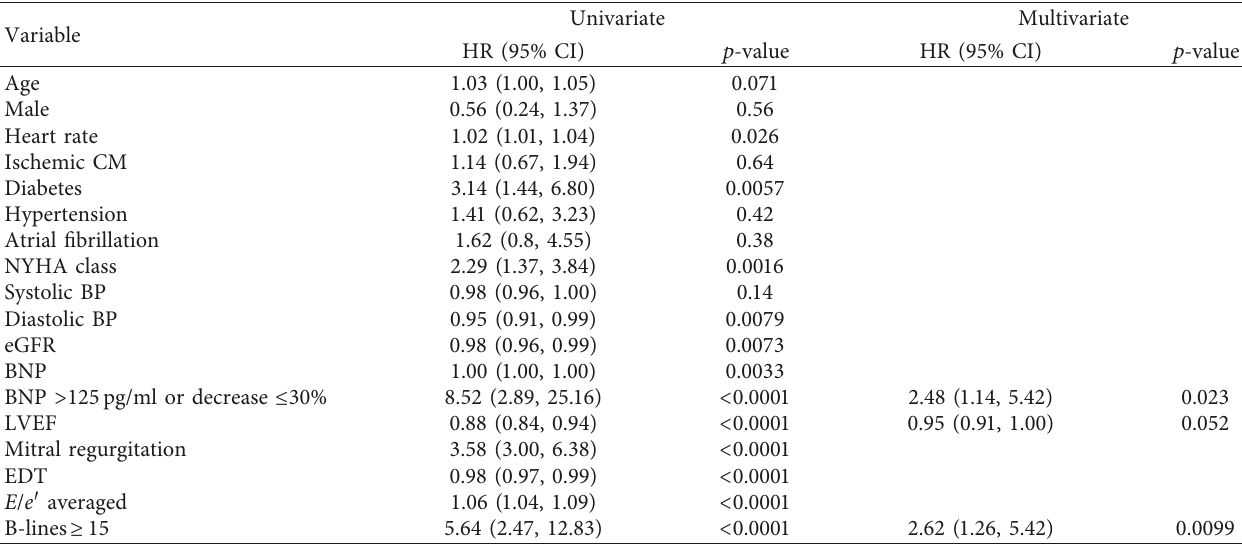
Table 3: Univariate and multivariate predictors of the combined end point among 224 patients of the BNP- and echo-guided group.